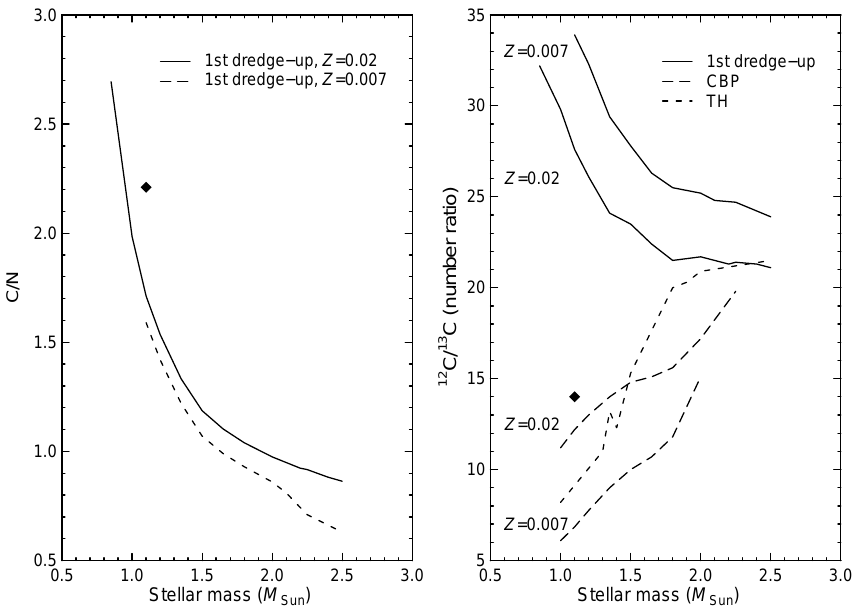
Fig. 8. Comparisons of C/N and 12 C/ 13 C ratios of (cid:21) And (diamonds) with the theoretical predictions for two metallicities. Left panel: the C/N values in the first dredge-up (Boothroyd & Sackman 1999). Right panel: the 12 C/ 13 C values for the first dredge-up and the cool bottom processing (CBP) model by Boothroyd & Sackman (1999) and the model of thermohaline mixing (TH) by Charbonnel & Lagarde